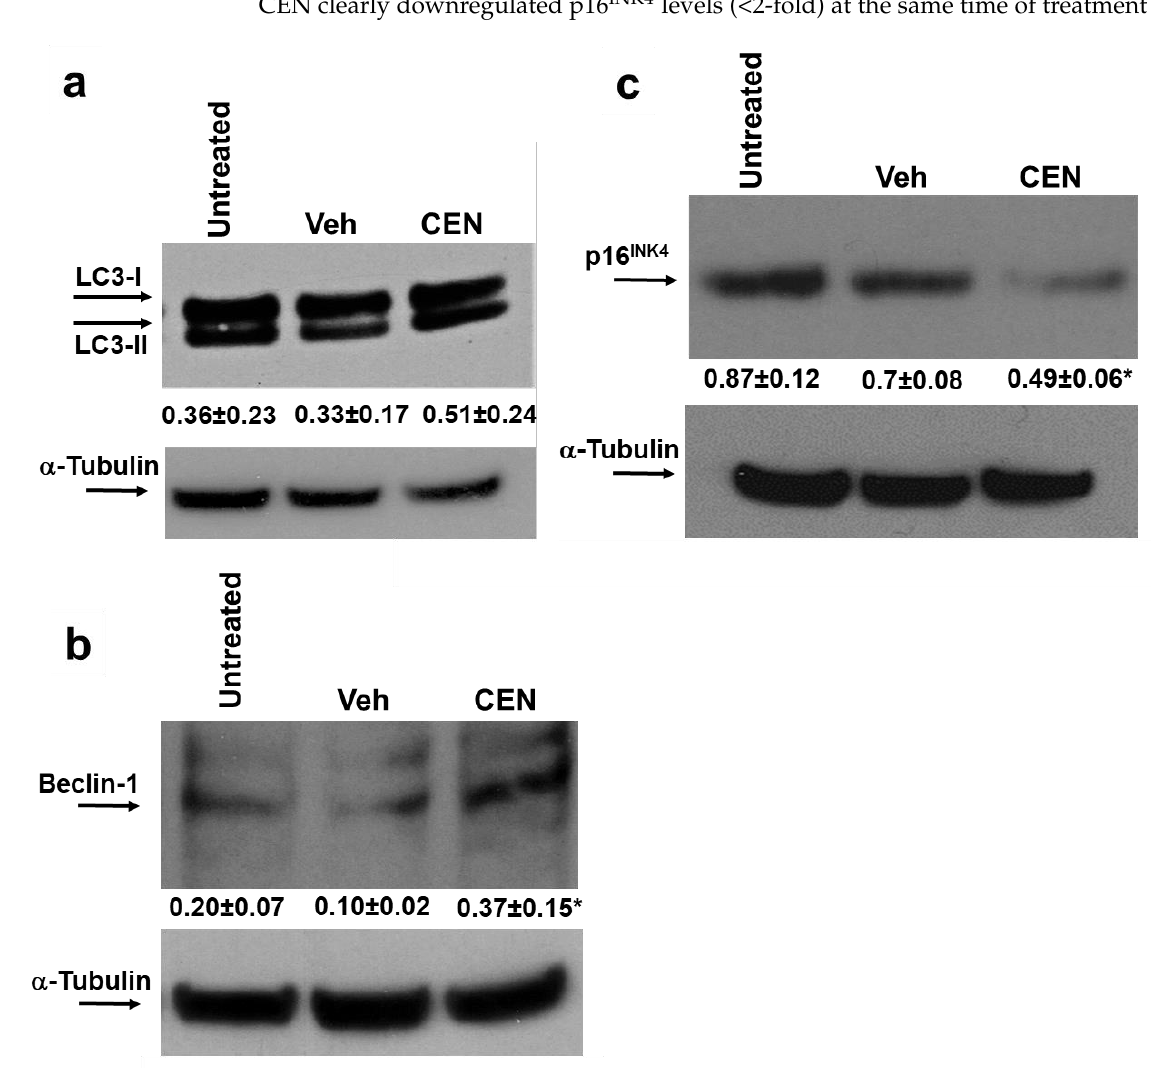
Figure 4. CEN modulates autophagy and senescence in SAOS400 cell lines. The cells were incubated for 120 h with cell culture medium, CEN, or Veh. Cell extracts were immunoblotted to detect au- tophagy and senescence markers, LC3I/II, Beclin-1 (panel ( a , b )), and p16 INK4 (panel ( c )), respectively. Densitometric analysis (numbers between panels indicate mean ± SD) was obtained normalizing the expression of LC3-II, Beclin-1, and p16 INK4 with the expression of α -tubulin, as described in the Materials and Methods Section. Symbols indicate significance: * p < 0.05 CEN with respect to Veh.